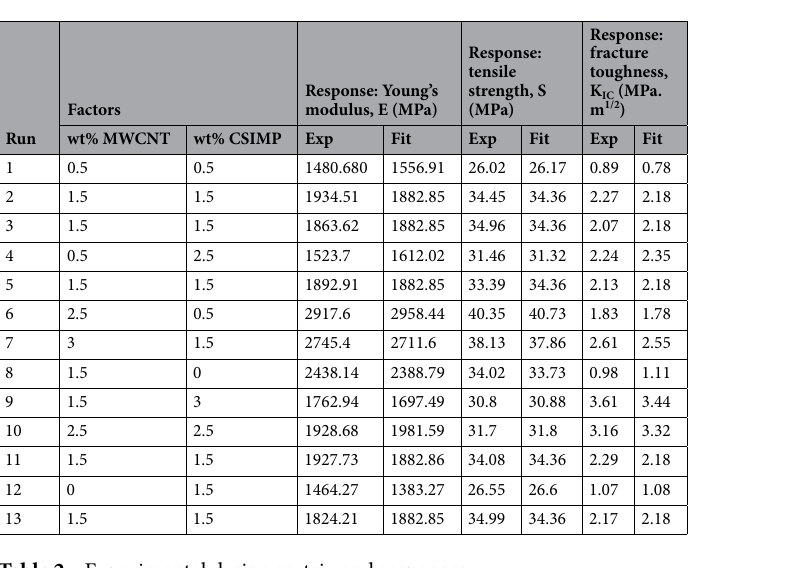
Table 2. Experimental design matrix and